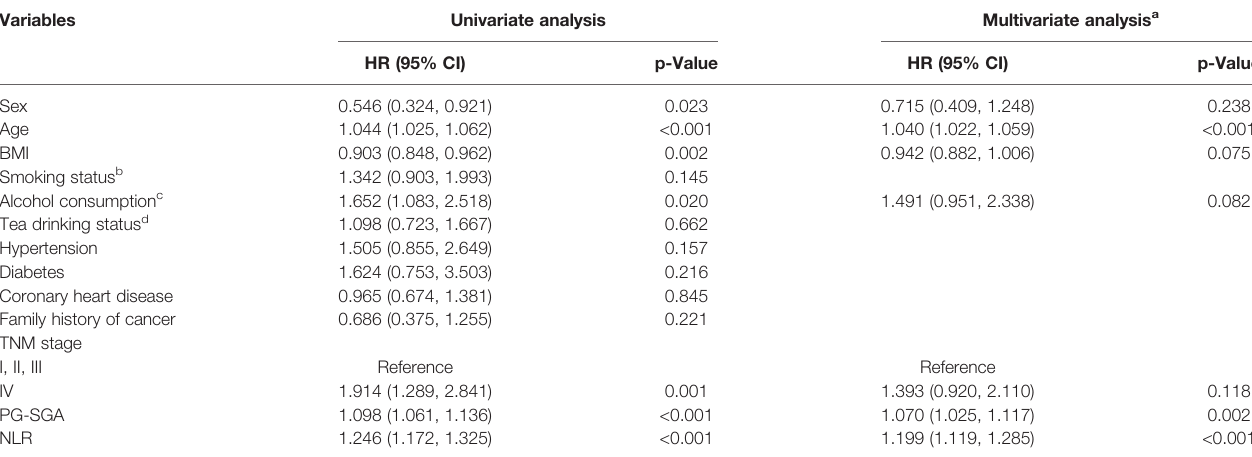
TABLE 2 | Association between clinical variables and OS in patients with NPC undergoing